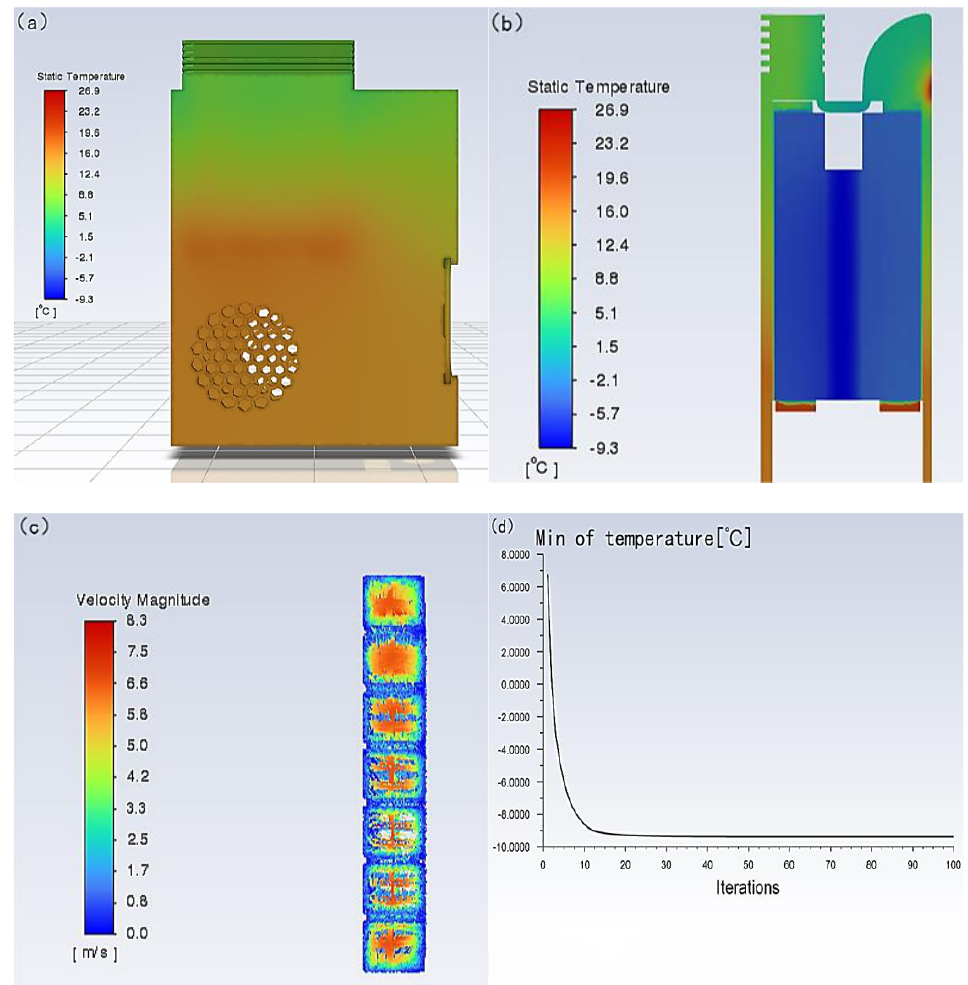
Figure 11. Simulation results of hot air surface. ( a ) Simulated temperature distribution cloud of the hot air surface of the portable refrigeration device. ( b ) Simulated temperature cloud of hot air sec- tion of portable refrigeration device. ( c ) Portable refrigeration device heat flow outlet velocity traces. ( d ) Maximum temperature variation curve of portable refrigeration device.